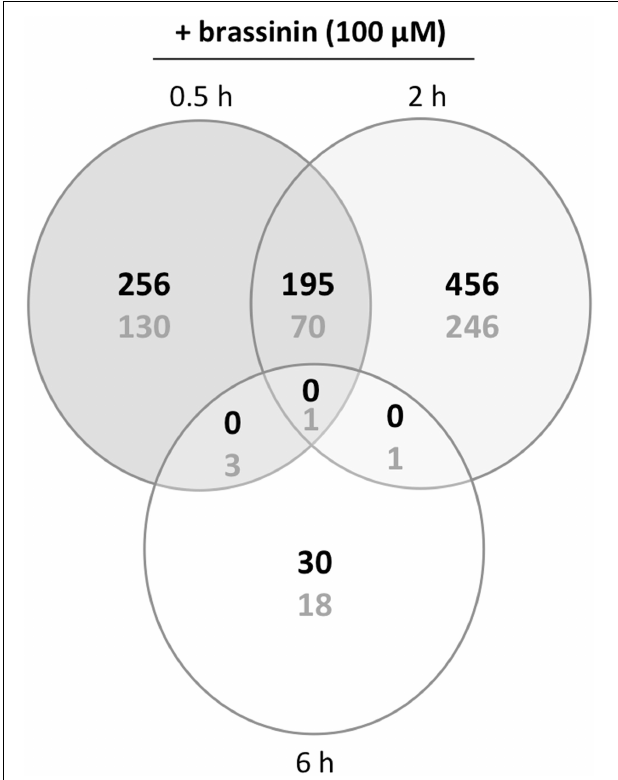
FIGURE 2 | Venn diagram of overlapping and non-overlapping genes with significantly regulated expression levels in brassinin-treated cultures compared to DMSO-treated cultures. The number of induced or repressed genes are indicated with black or gray numbers, respectively. Probes with a P ≤ 0.01and a log ratio ≥ 1 or ≤ -1 were considered as differentially